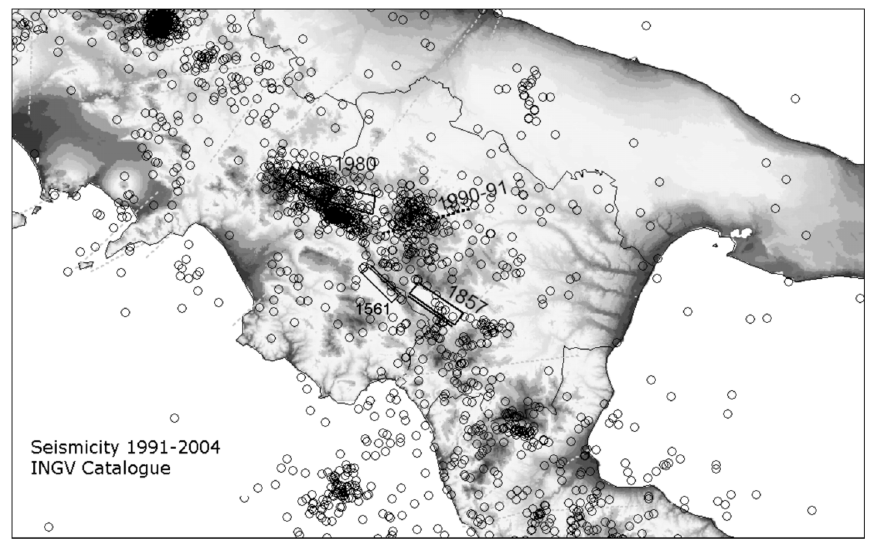
Fig. 2. Seismicity map of the investigated area (earthquakes with M > 1.8 occurred between the years 1991- 2004). The main seismogenetic areas are represented by Val d’Agri normal fault (mainshock 1857, I = XI MCS), Irpinia normal faults system (mainshock 1980, M s = 6.9) and Potenza strike-slip fault (mainshock 1990 M d =